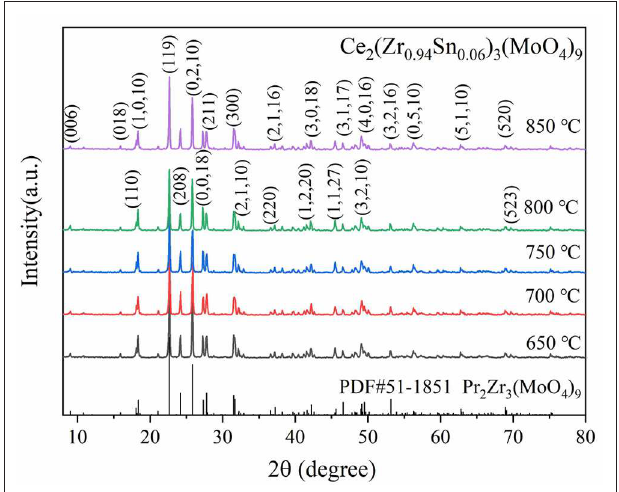
FIGURE 1 | XRD patterns of Ce 2 (Zr 0.94 Sn 0.06 ) 3 (MoO 4 ) 9 ceramics sintered at 650–850 ◦